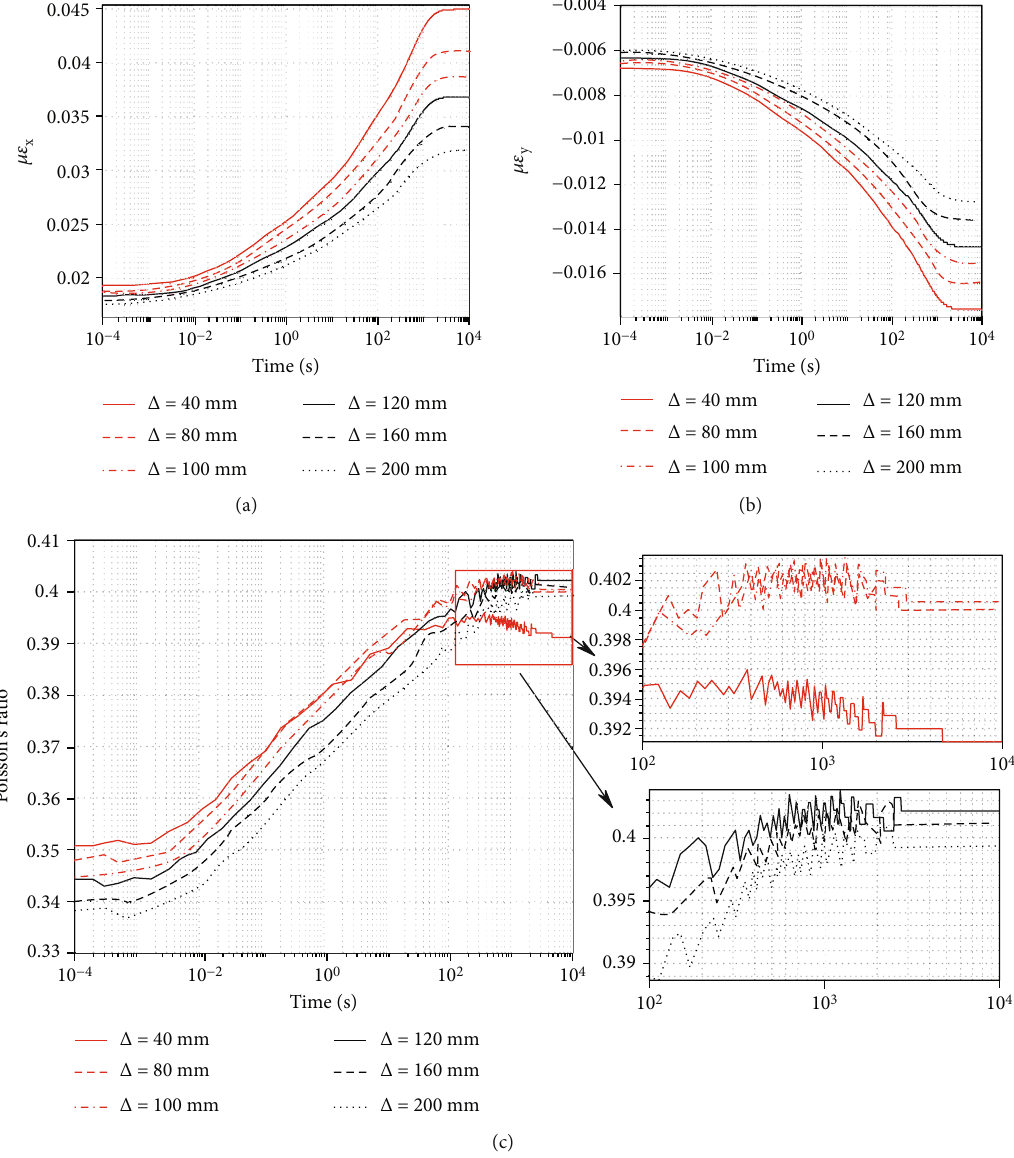
Figure 10: The curves of the (a) longitudinal strain, (b) transverse strain, and (c) Poisson ’ s ratio versus time under di ff erent critical